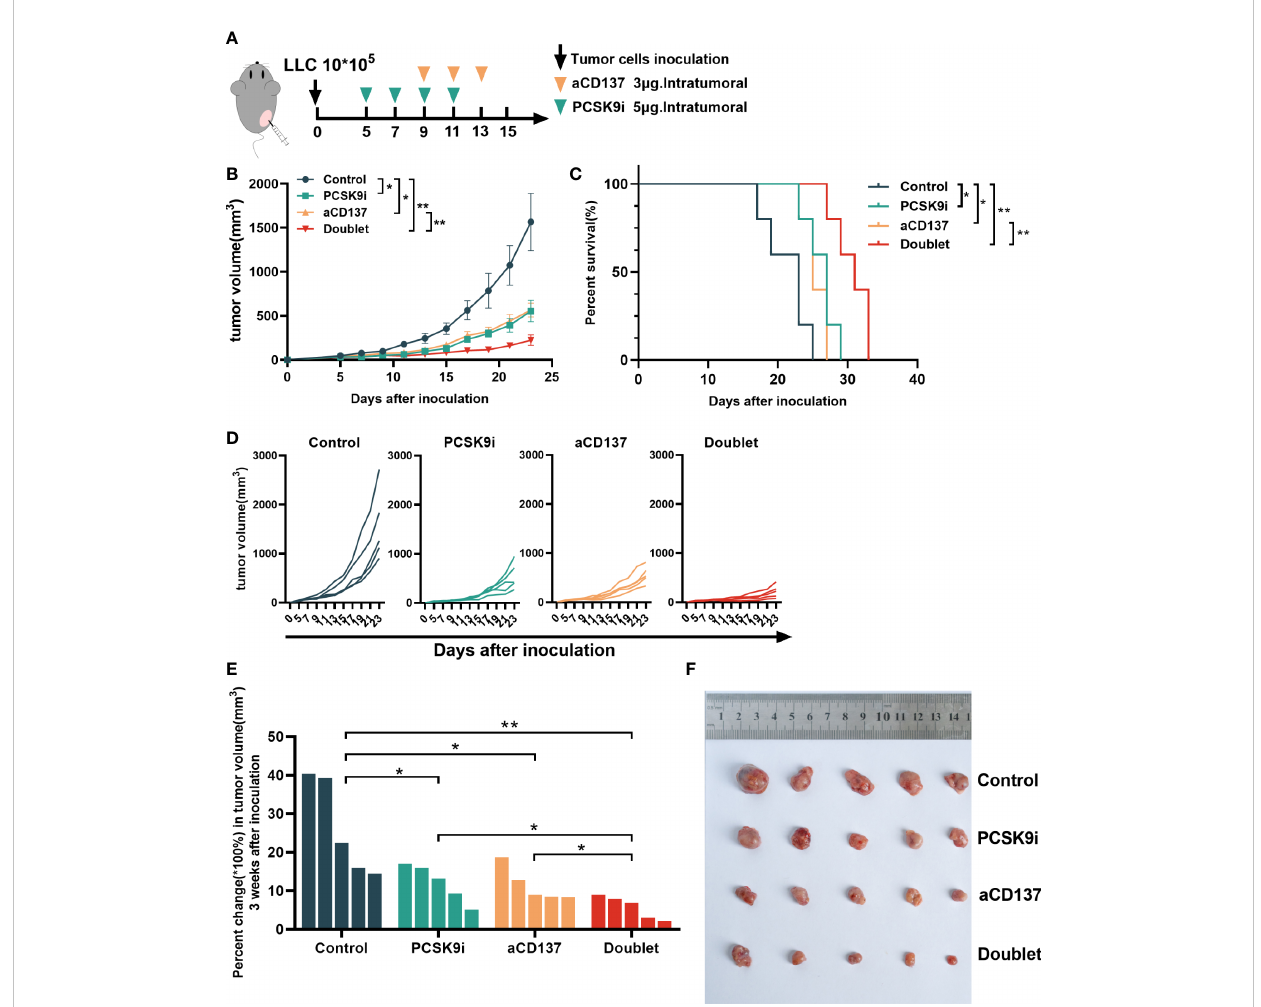
FIGURE 4 Tumor growth was attenuated with PCSK9 inhibition in combination with CD137 costimulation in syngeneic mice. (A) Experimental protocol. n = 5 mice per group. Intratumoral. (B) Tumor growth curve of each group ( P -value was calculated by two-way ANOVA). (C) Overall survival (log-rank test). (D) Tumor growth curve of each mouse. (E) Percent change in tumor volume on day 21 compared with day 5 (baseline) after inoculation (unpaired t -test). (F) Tumors harvested on day 21. Data shown as mean ± SEM. * P < 0.05, ** P < 0.01. LLC, Lewis lung carcinoma cells; PCSK9i, PCSK9 inhibitor; aCD137, anti-CD137 agonist; Doublet, the group treated with the PCSK9 inhibitor and the anti-CD137